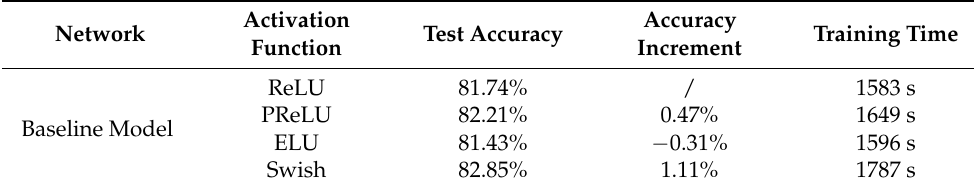
Table 3. The quantity of samples in each category.